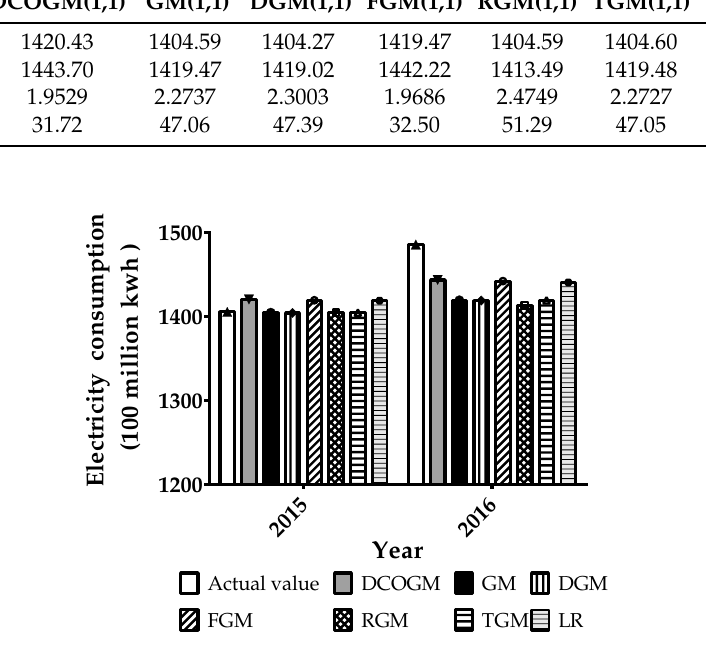
Figure 3. Forecasting results of the electricity